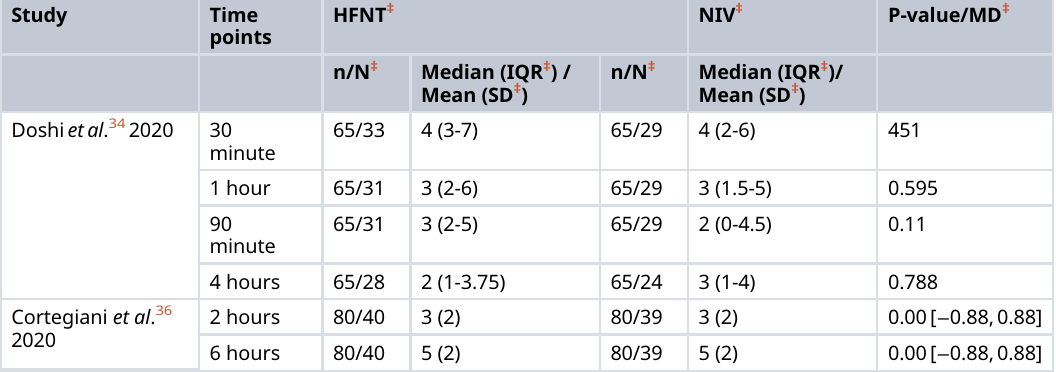
Table 10. Dyspnoea score using Modified Borg Score * (comparing HFNT vs NIV). 33,36